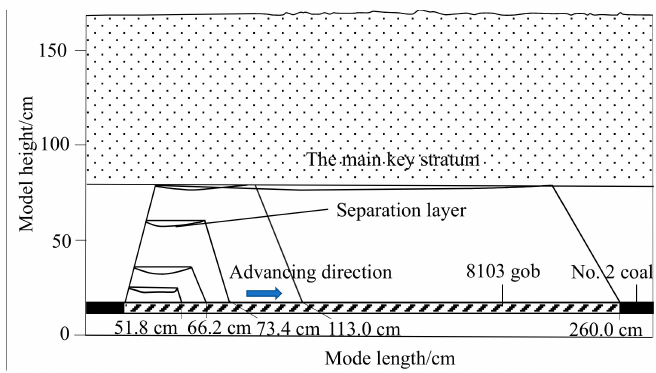
Figure 4. Evolution of the mining separation layer in the 8103 working face.